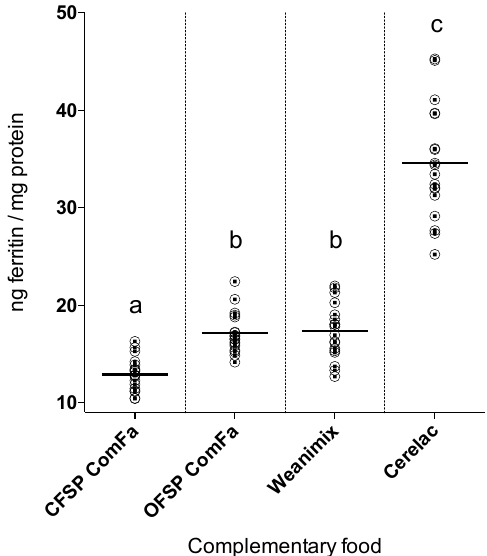
Figure 1. Ferritin formation per gram (adjusted for moisture content) of infant complementary weaning foods from: Cerelac ® ; CFSP ComFa; OFSP ComFa and Weanimix. Caco-2 cell ferritin formation was highest after exposure to the commercial infant cereal Cerelac ® . OFSP ComFa and Weanimix ferritin levels were equivalent and approximately 50% less than Cerelac ® induced ferritin formation. CFSP ComFa treated cells formed the lowest amount of ferritin: 25% less than the levels formed in OFSP ComFa and Weanimix. Plots are individual values that have been normalised to the average blank digest ( i.e ., no added iron) ferritin level ( n = 18); short horizontal lines indicate the group mean. Means per group with different letters are significantly different ( p <